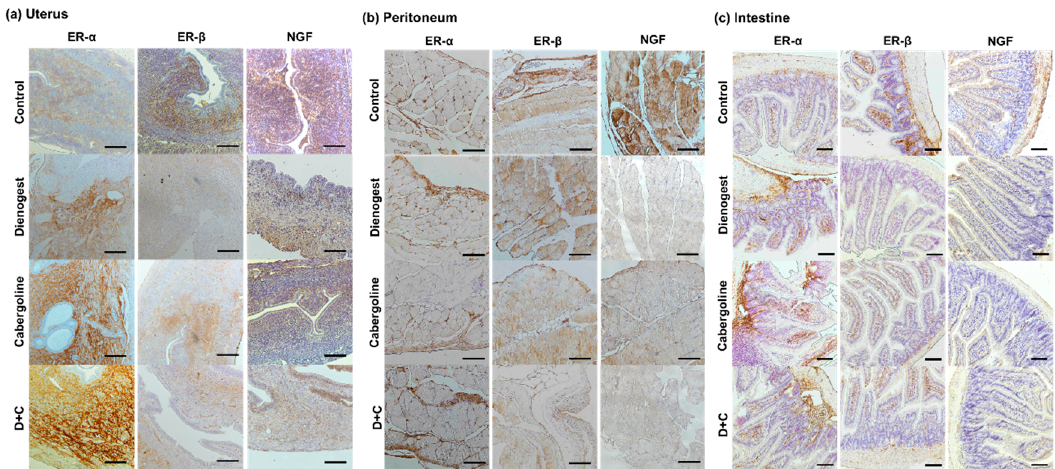
Figure 3. Light microscopy images of immunohistochemical analysis with anti-ER (estrogen receptor)- α , ER- β , and NGF (nerve growth factor) antibodies. (Magnification, 1000×). ( a ) Uterus, ( b ) peritoneum, and ( c ) intestine tissue. The results presented are the DAB-positive signal (brown) and hematoxylin (blue) for nuclear counterstaining; scale bar, 100 µm.